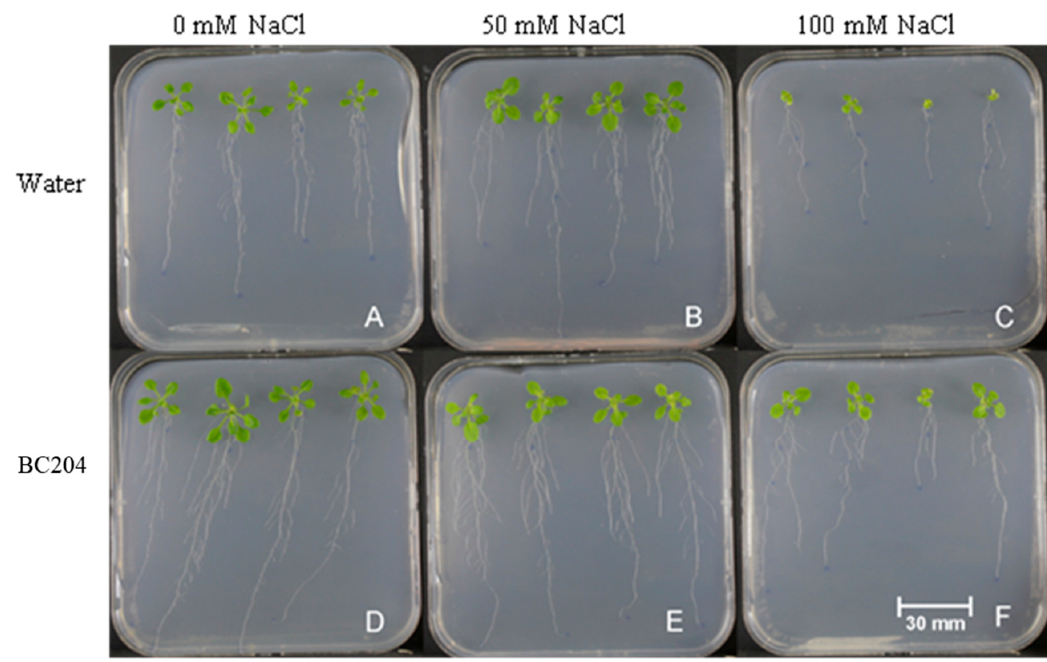
Figure 3. Growth of Arabidopsis thaliana seedlings in vitro in response to salt (NaCl) and BC204 treatments. Seedlings were grown on half-strength Murashige and Skoog (MS) media ( A ), supplemented with 50 mM NaCl ( B ), 100 mM NaCl ( C ), 0.001% ( v/v ) BC204 ( D ), 50 mM NaCl and BC204 ( E ), and 100 mM NaCl and BC204 ( F ).